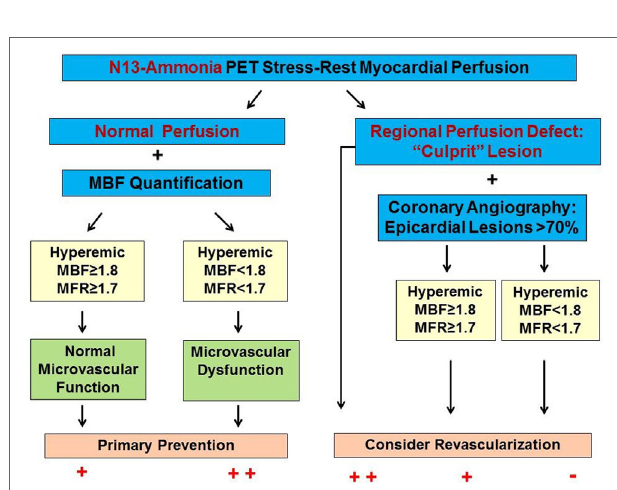
FiGURe 3 | Algorithm for the Integration of 13 N-ammonia positron emission tomography/computed tomography perfusion images and myocardial blood flows (MBFs) in multivessel CAD. In individuals with normal stress–rest myocardial perfusion images, the quantification of hyperemic MBF and myocardial flow reserve (MFR) may unravel microvascular dysfunction as functional precursor of CAD that may reinforce lifestyle-changes and/or preventive medical care. A stress-induced regional perfusion defect, however, indicates the most advanced CAD lesion. In this respect, adding hyperemic MBF and MFR may signify flow-limiting effects of lesions > 70% diameter but less severe than observed for the culprit lesions and with normal radiotracer- uptake [reproduced with kind permission from Schindler (6)].